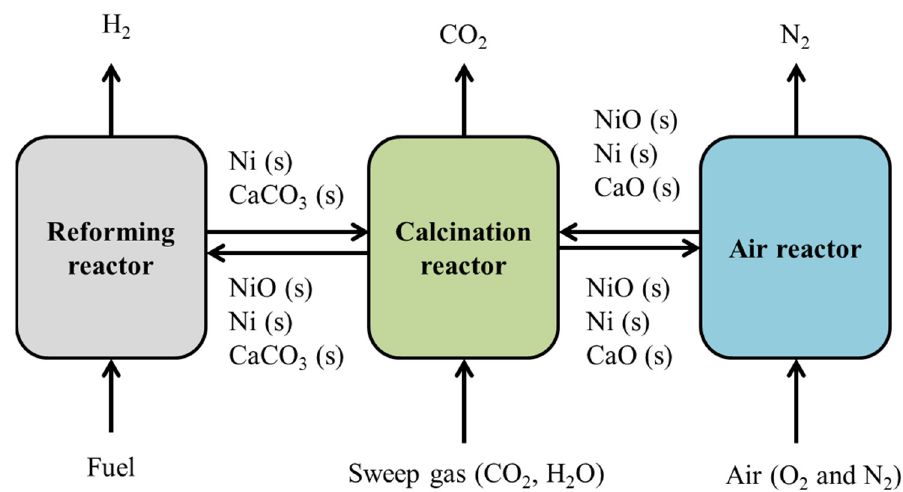
Figure 6. A schematic diagram for sorption-enhanced chemical looping reforming